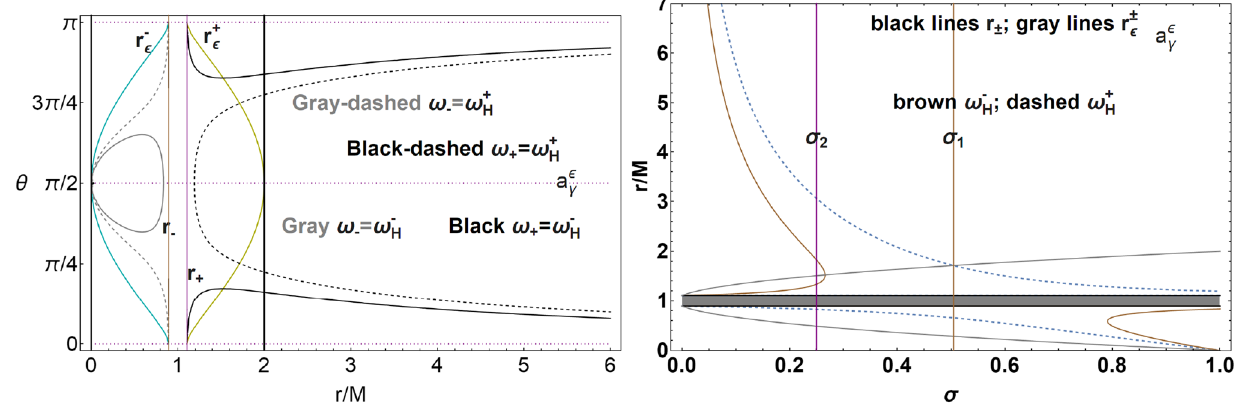
Fig. 17 Study of replicas for the BH spacetime with spin a (cid:9) γ = frequencies ω + black and ω − gray, in the plane θ − r . Replicas of the frequency ω + are the dashed curves, replicas of the frequency ω − 0 . 994298 M : r ± are the outer and inner BH horizon. r ± (cid:9) are the outer H H are the plain curves. Right panel: σ 1 and σ 2 are selected values of the and inner ergosurfaces. ω ± are the frequencies of the outer and inner H plane σ whose replicas are showed in Fig. 17. Gray region is the range horizon respectively. ω ± are solutions of light like orbital frequencies ] r + , r − [ , gray curves are the radii r ± for stationary observers. There is σ ≡ sin 2 θ . See Fig. 15 and in Fig. 18. (cid:9) . Brown curves are the orbits and plane with the inner horizon frequency, the dashed curves are the orbits Left panel: vertical lines are the horizons r ± , the singularity r = 0 and and plane with the outer horizon frequencies. σ = 1 is the equatorial the ergosurface r + (cid:9) = 2 M on the equatorial plane θ = π/ 2. and r ± (cid:9) . plane while σ = 0 are the BH poles Yellow curve is the r + (cid:9) , cyan curve is r − (cid:9) . Replicas of light like orbital